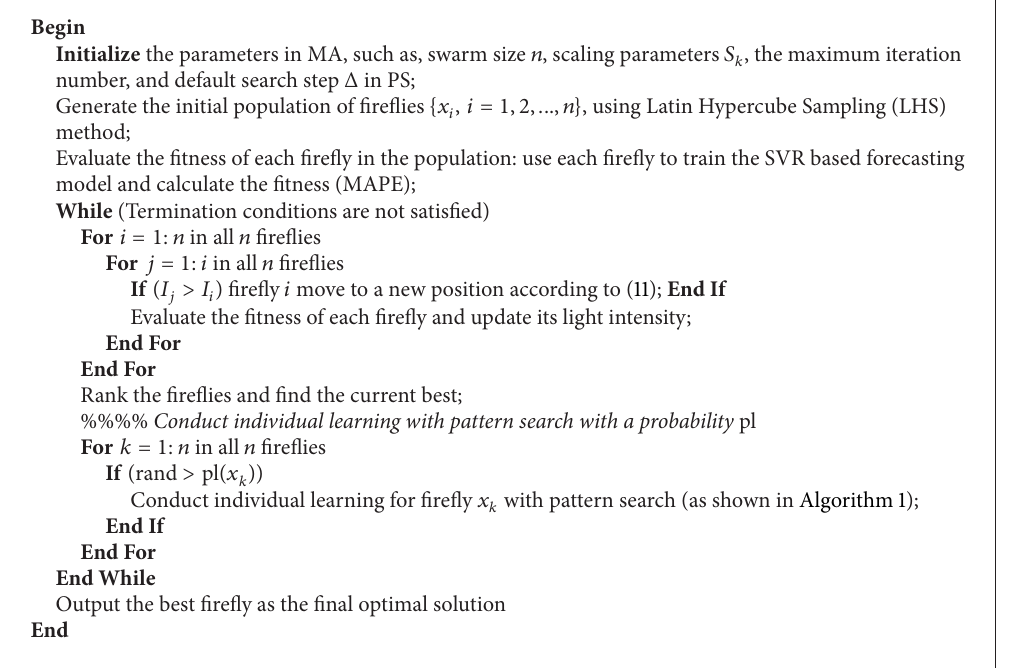
Algorithm 2: Pseudocode of proposed firefly algorithm based memetic